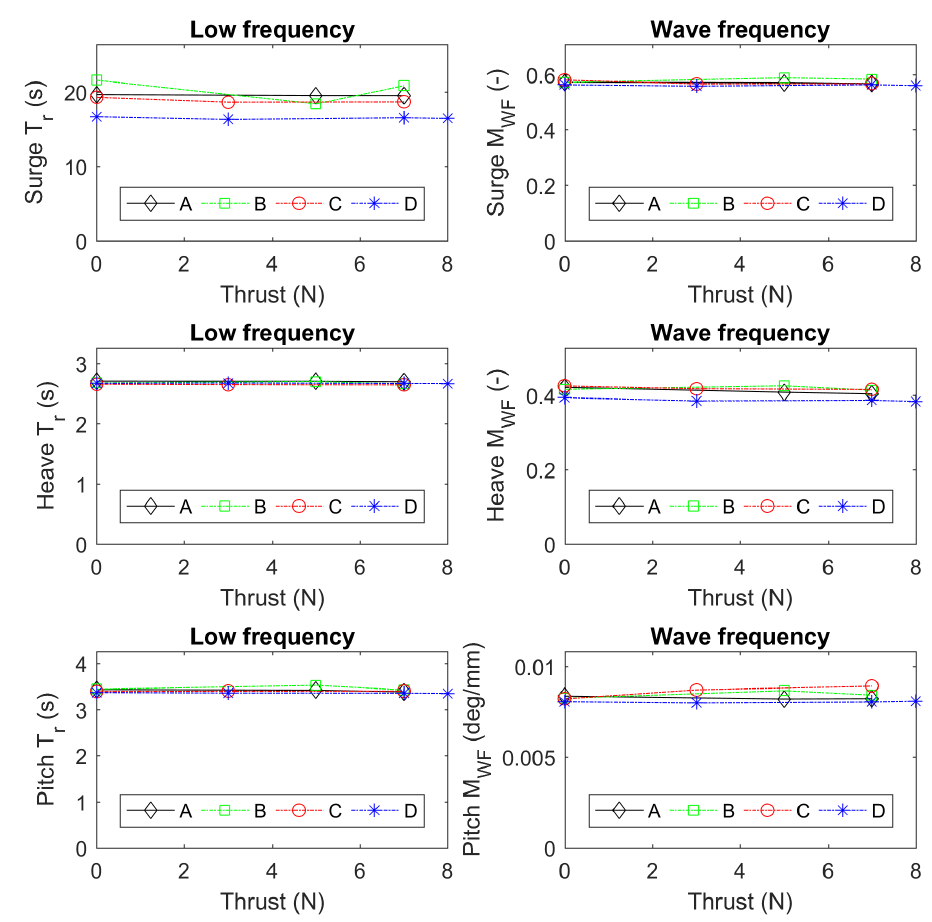
Figure 24. Metrics T r (left column) and M WF (right column) for JONSWAP T p = 1.81 s, H s = 15 cm per facility for surge (top row), heave (middle row), and pitch (bottom row) at thrust levels of 0, 3, 5, 7, and 8 N (8 N applied at facility D